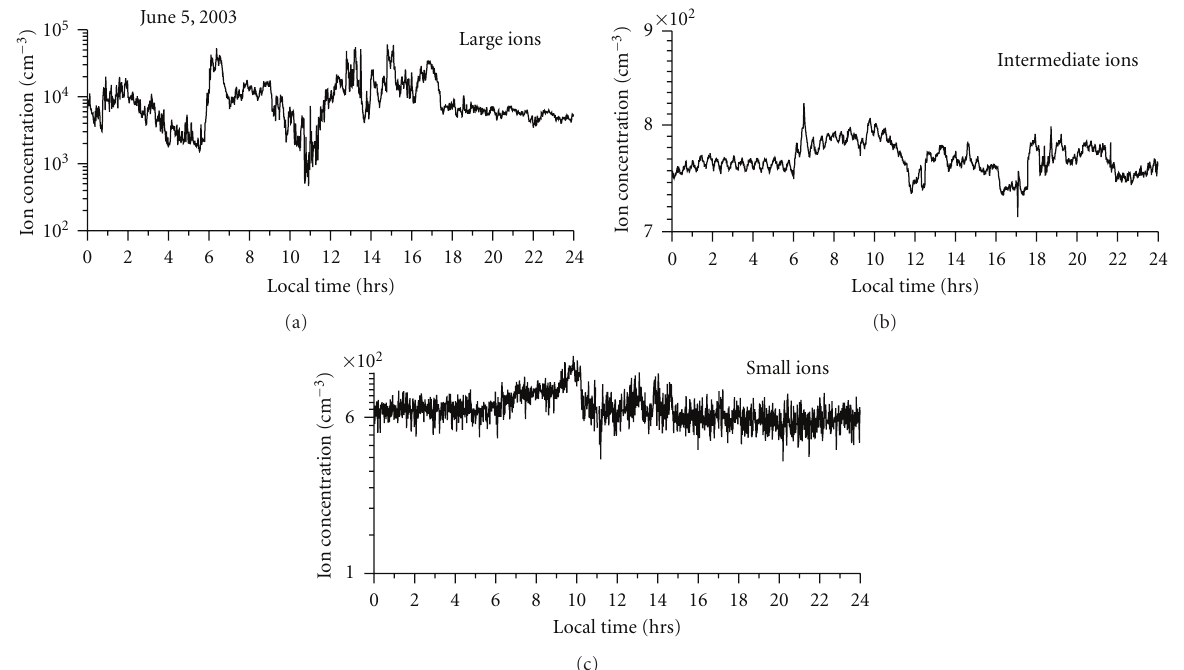
Figure 7: Diurnal variation of small, intermediate, and large ions on a cloudy day (June 5, 2003) observed during cruise period.